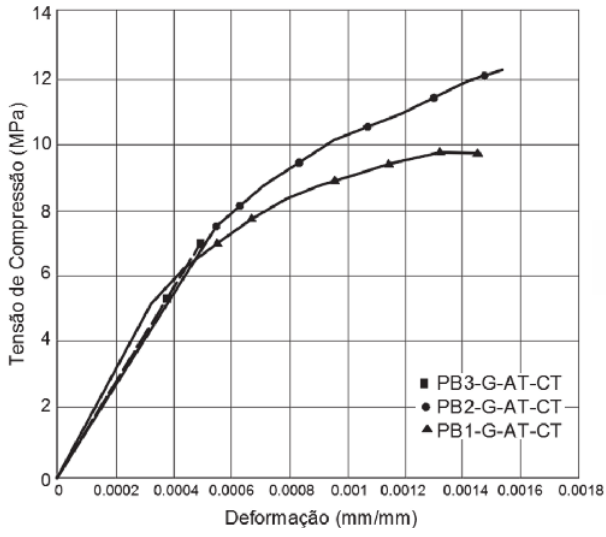
Curvas de tensão x deformação para as paredes PB- G-AT-CT, considerando as três resistências de